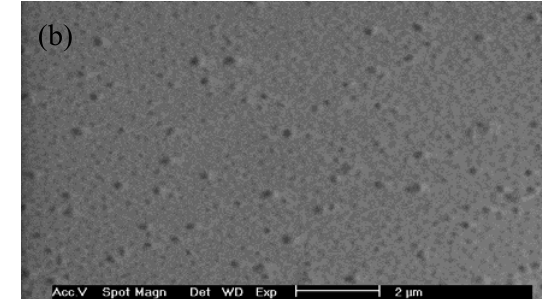
O :Eu 3+ F127 modified thin 2 3